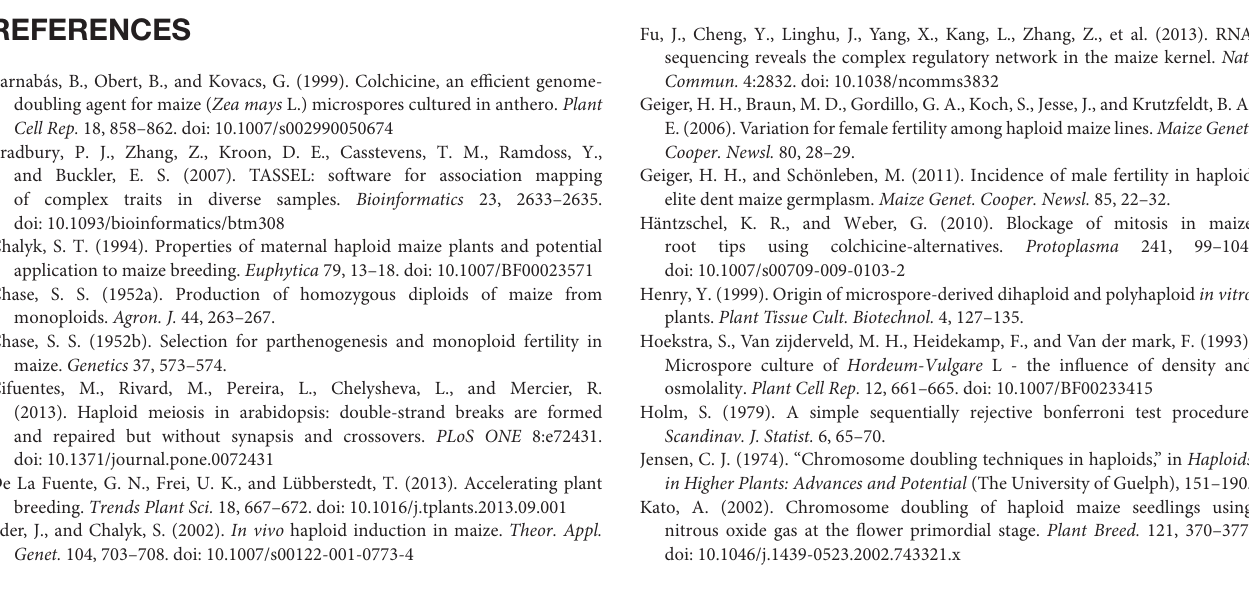
Figure S1 | Principal coordinate analysis plot for 481 maize inbred lines. Blue, green, red, and black color represent Stiff Stalk, Tropical-Subtropical, Non-Stiff Stalk, and the mixed subgroup, respectively. Figure S2 | The distribution of minor allele frequency for the 425,597 high quality SNPs. Figure S3 | Boxplots of summary statistics for 425,597 SNPs in all inbred lines from the diversity panel and in each subpopulation. (A) Minor allele frequency, (B) Gene diversity, (C) PIC. Figure S4 | Linkage disequilibrium (LD) across the 10 chromosomes in the maize diversity panel of 481 lines. The X-axis indicates the physical distance between SNPs within the same chromosome and the Y-axis indicates the LD ( r 2 ). Figure S5 | Quantile-quantile plots of estimated − log 10 ( P -value) from association analysis for haploid male fertility using six methods, (A) across genetic backgrounds, and within the (B) “Mo17” and (C) “Zheng58” backgrounds. The gray solid line is the expected line under the null distribution where there are few true marker associations. The observed P -values are expected to nearly follow the expected P -values. Deviations from expectation demonstrate that the statistical analysis may cause spurious association. The significance level is marked by the horizontal dotted line. Figure S6 | Manhattan plots for haploid male fertility across genetic backgrounds assessed with six models. The dashed horizontal line indicates the genome-wide significance threshold. Figure S7 | Manhattan plots for haploid male fertility in the “Mo17” background assessed with six models. The dashed horizontal line indicates the genome-wide significance threshold. Figure S8 | Manhattan plots for haploid male fertility in the “Zheng58” background assessed with six models. The dashed horizontal line indicates the genome-wide significance threshold. Table S1 | Average linkage disequilibrium between marker pairs according to their physical distance, shown for all 10 chromosomes. Table S2 | ANOVA for the arcsine transformed haploid male fertility values. Table S3 | Physical positions of 6 SNPs significantly associated with HFM based on Q model under Zheng58 background and the predicted function or homology of adjacent candidate